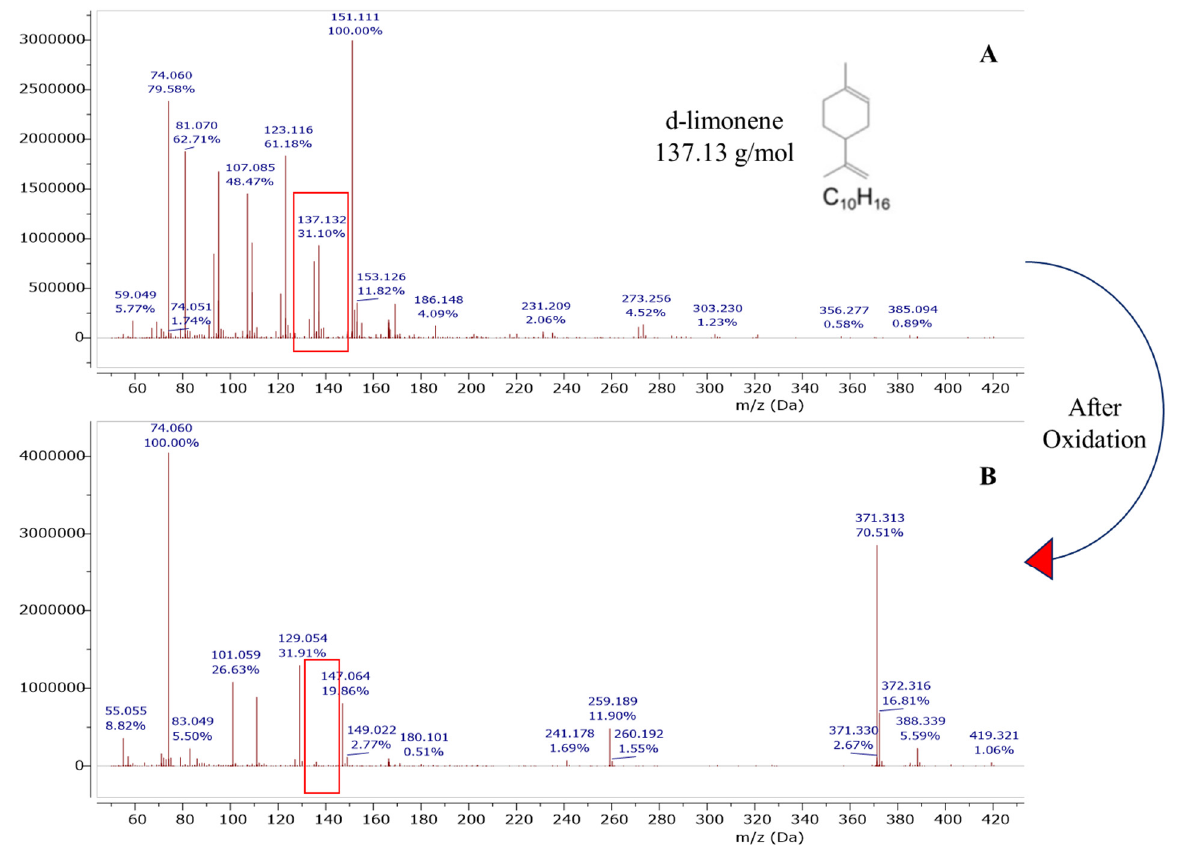
Figure 5. DART-MS study of limonene degradation before ( A ) and after oxidation ( B ) for orange peel liquor. peel